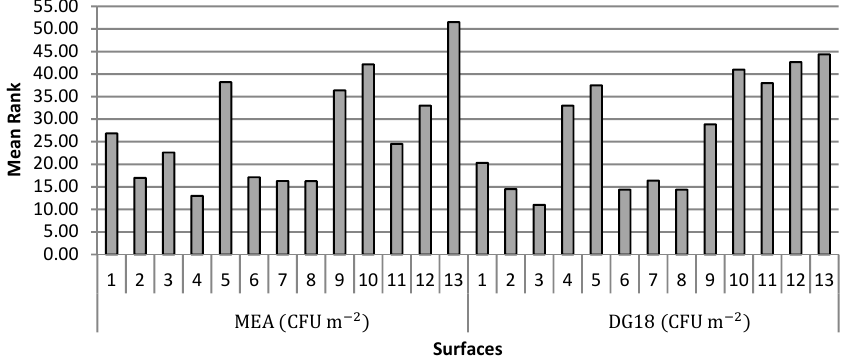
Figure 3. Mean ranks of fungal load (CFU m − 2 ) on MEA and DG18 on the surface swabs in each bakery.